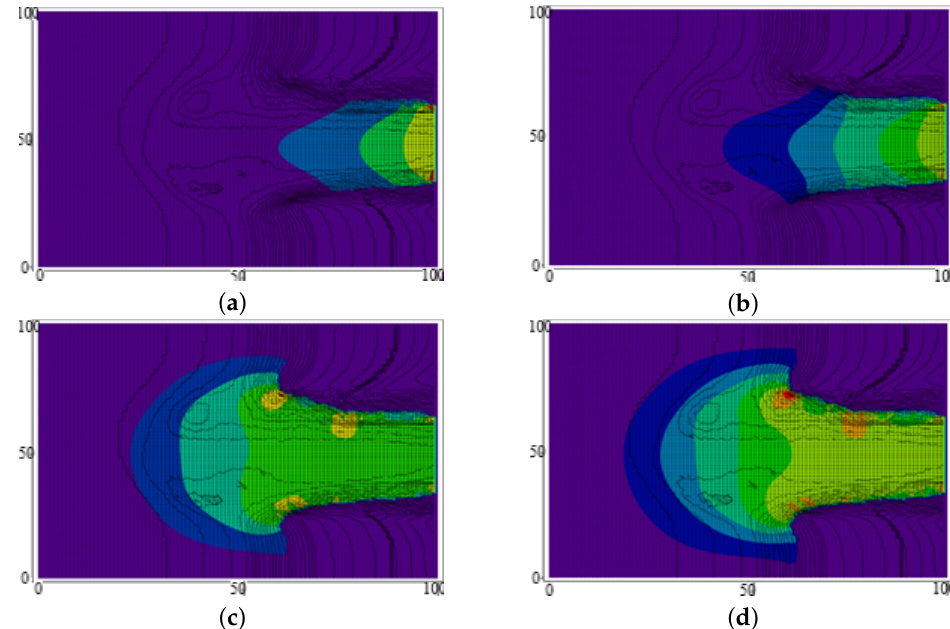
Figure 1. Depth map of the computational domain.